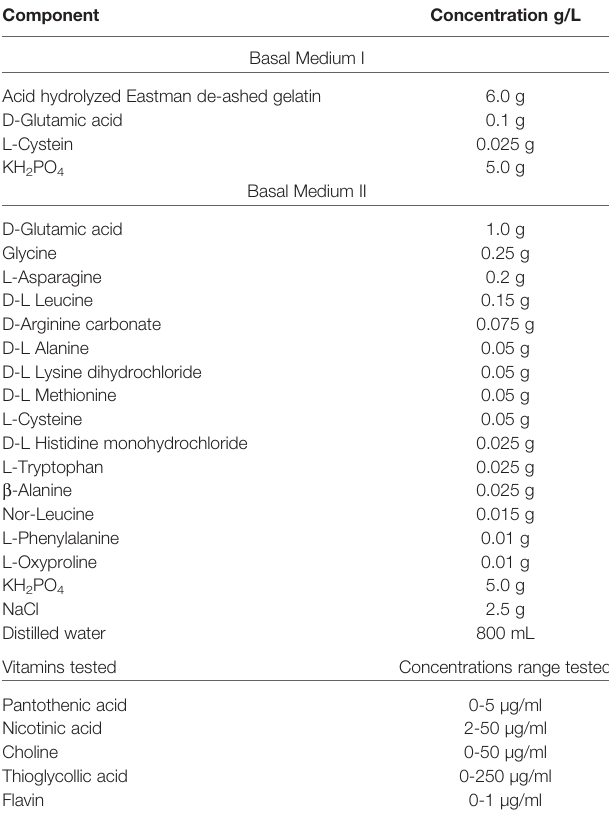
TABLE 4 | Rane and Subbarow, 1940. Component Concentration g/L